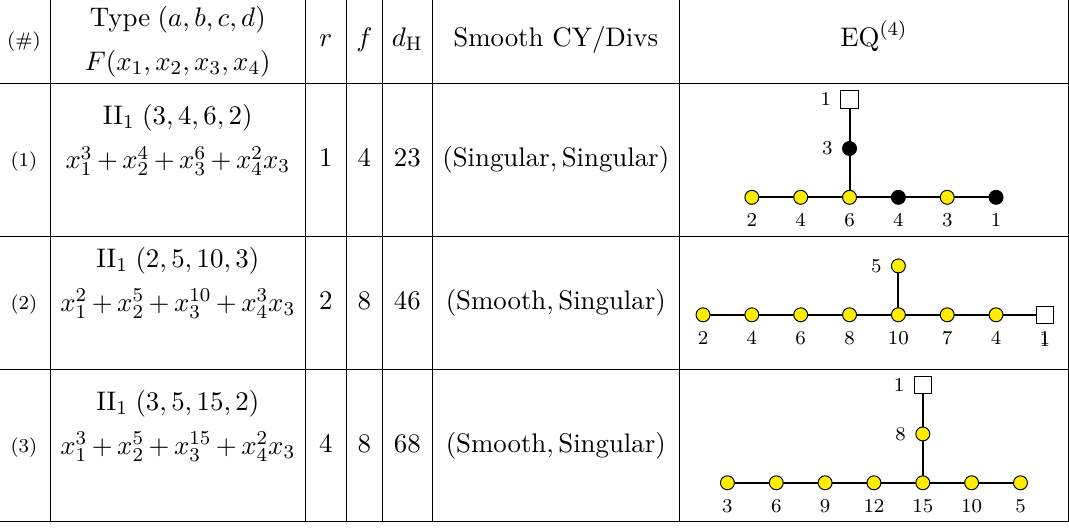
Table 11 . Basic data and EQ (4) for the first three ‘sporadic’ SU( N ) trinions. They all have ∆ A r = 0 , b = 0 and trivial one-form symmetry. The EQ (4) that only have SU( N ) gauge groups (yellow 3 nodes) correspond to Lagrangian N = 2 SCFTs in 4d. The (smooth/singular, smooth/singular) indicates whether the Calabi-Yau threefold is singular and there are still singular divisors in the resolution,